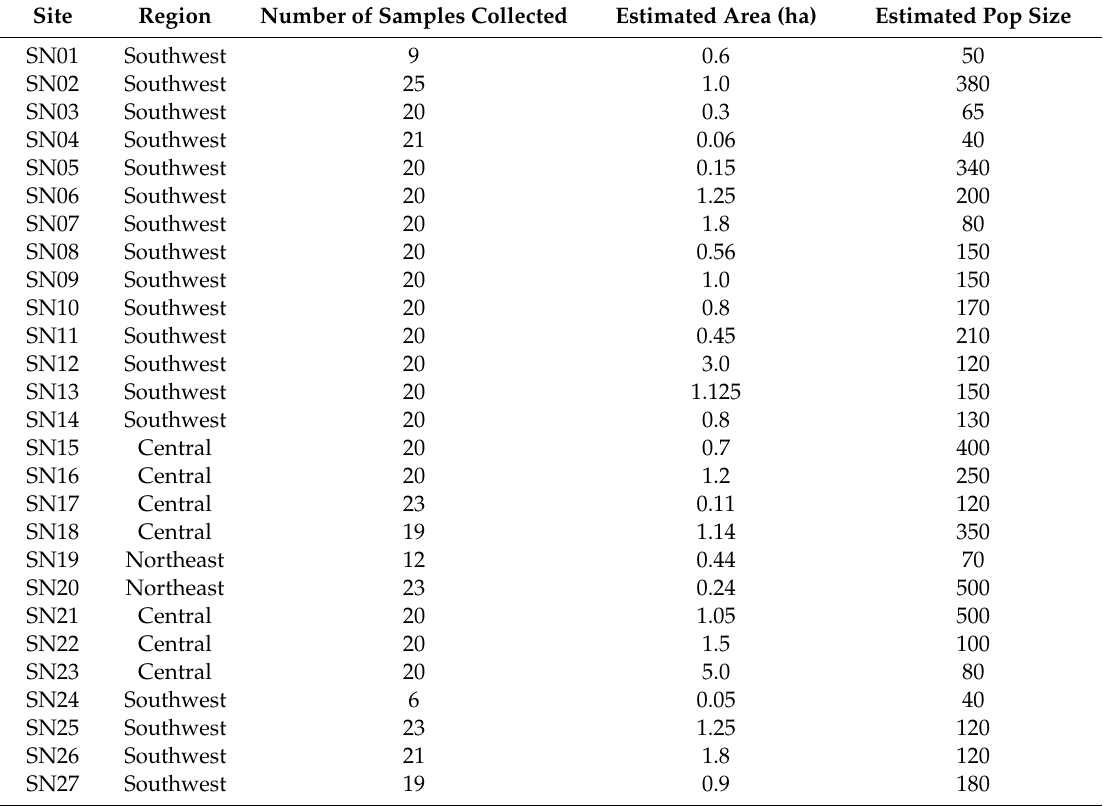
Table 1. Site codes, region, sample numbers, estimated area, and number of plants per site (see Figure 1 for location of sites within